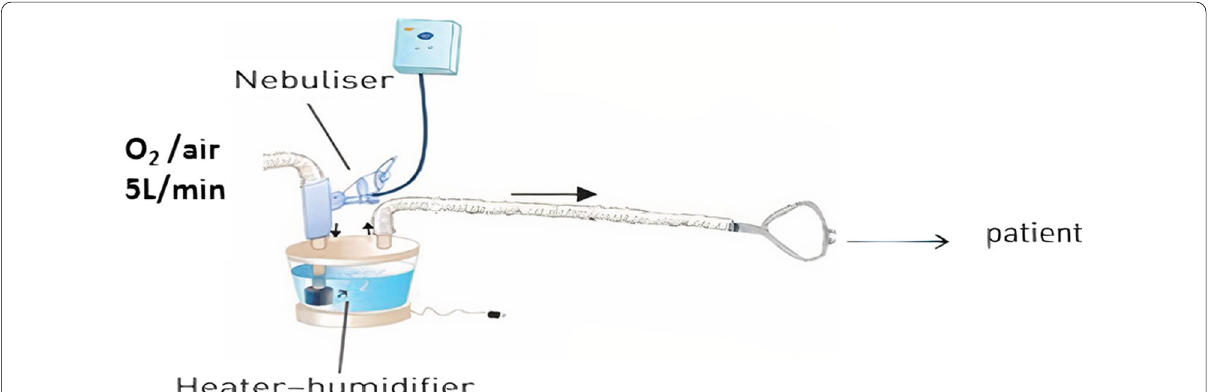
Fig. 2 Schematic diagram of in-vivo setting showing the position of the aerosol generator in case of using HFNC circuit.